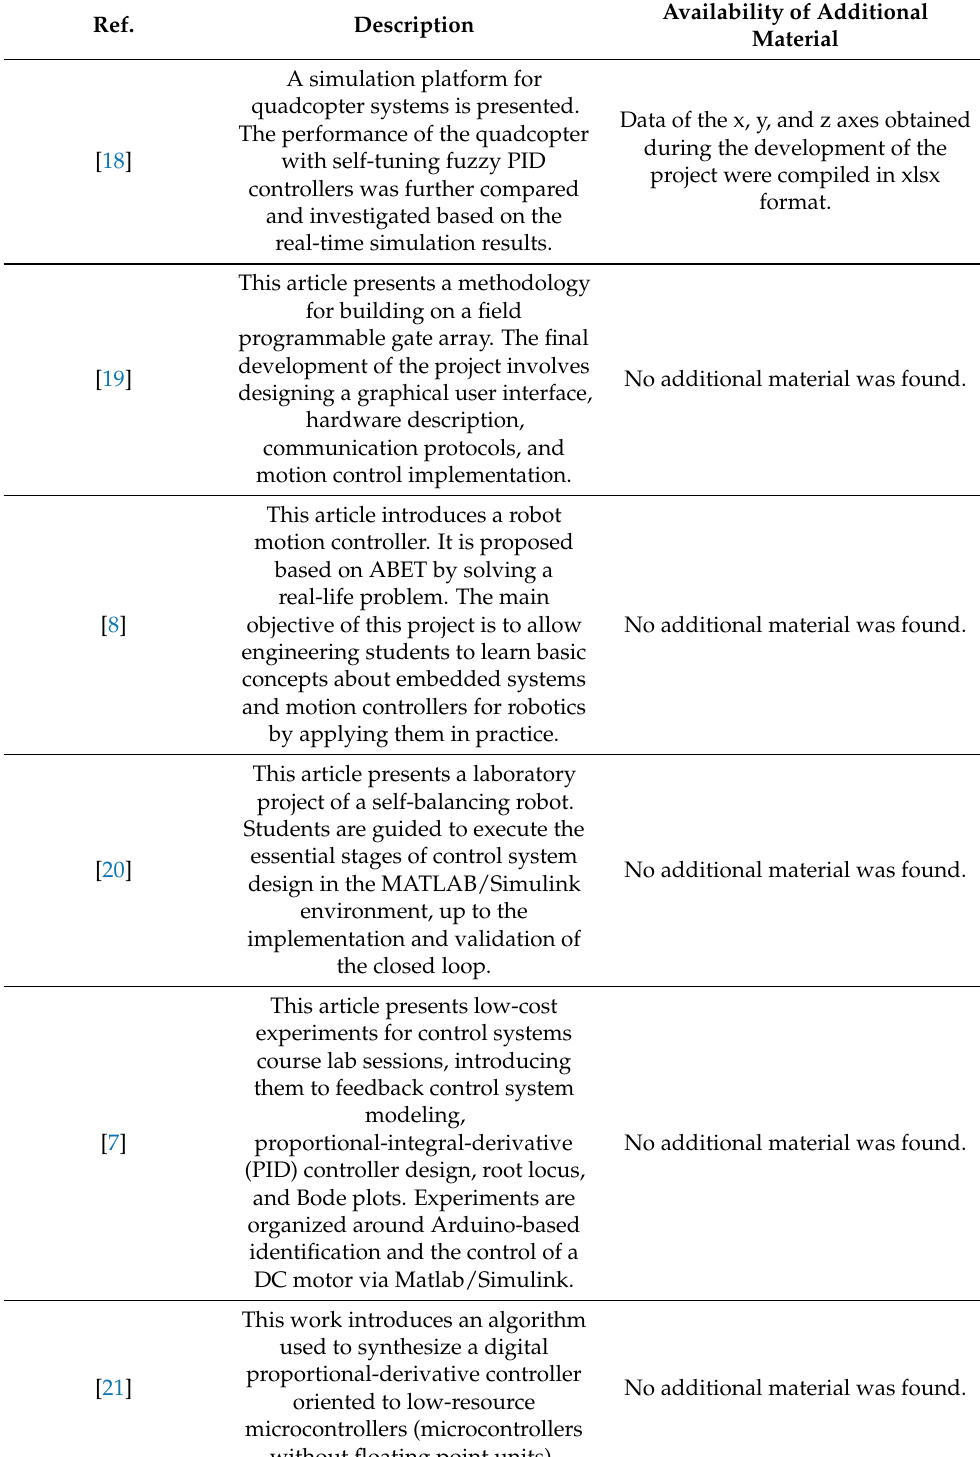
Table 1. Comparison of various works focused on the teaching of control.